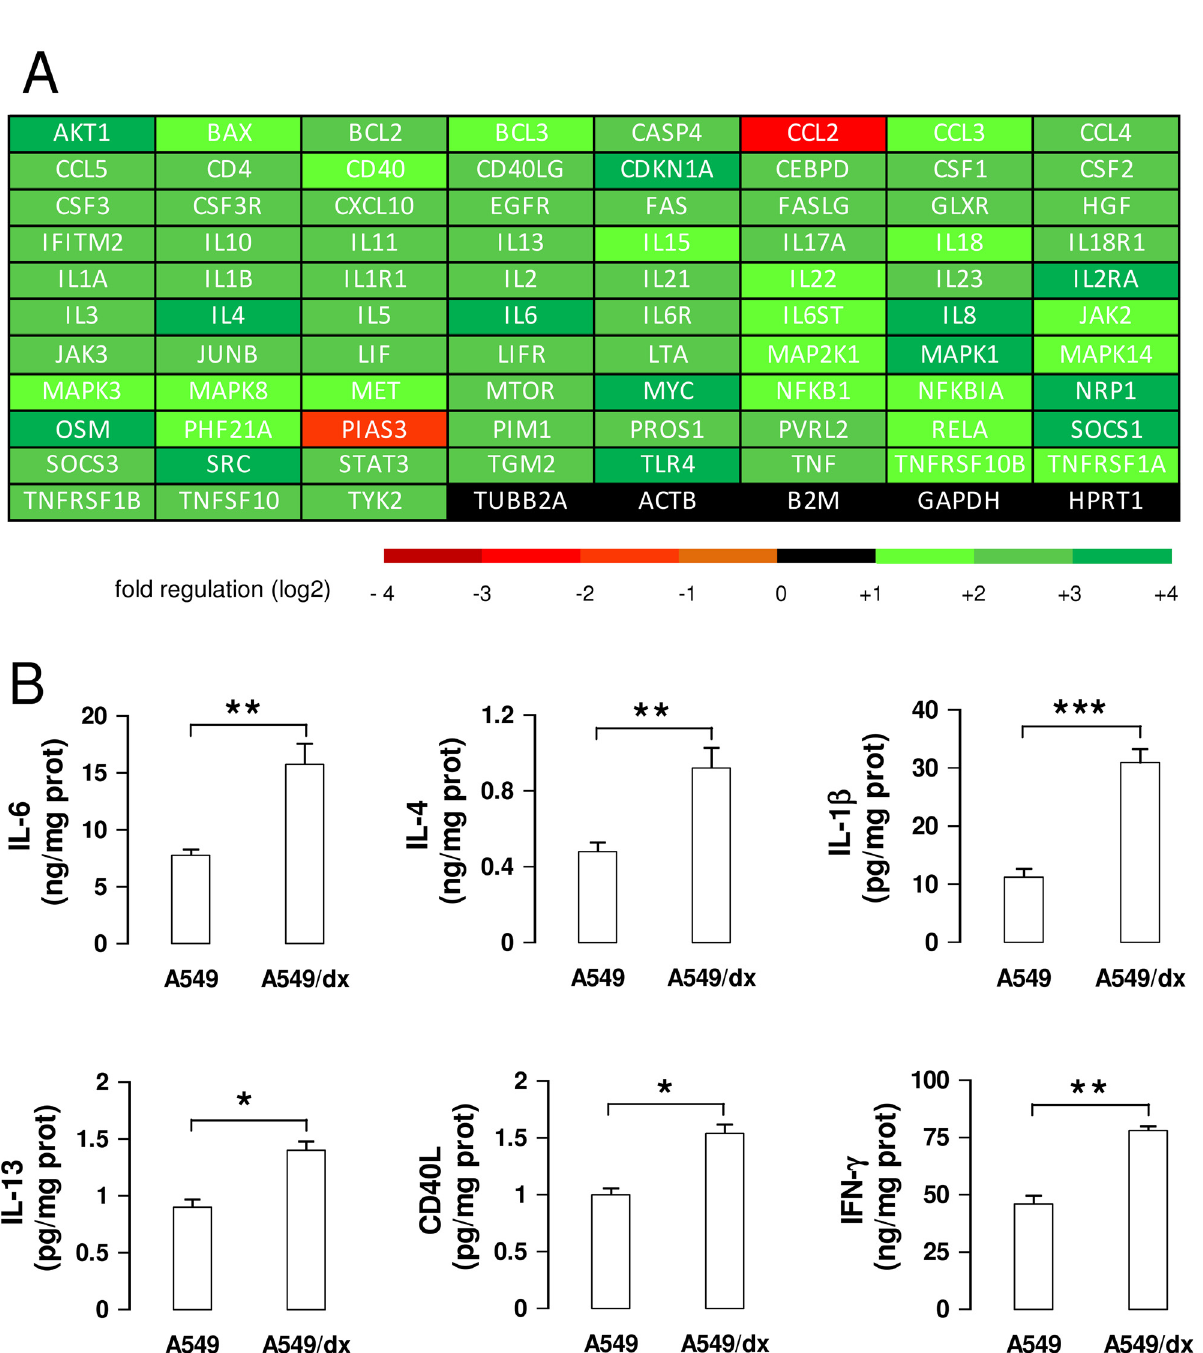
Fig 5. Multidrug resistant cells have a higher activity of IL-6/STAT3 signaling than chemosensitive cells. A. The cDNA from A549 and A549/dx cells was analyzed by a PCR array specific for IL-6/STAT3 signaling, as reported under Materials and methods. The fold regulation of the 83 genes analyzed, expressed in logarithmic scale, was represented in a colorimetric scale. The figure is the mean of 4 experiments. B. The levels of IL-6, IL-4, IL-1 β , IL-13, CD40L, IFN- γ were measured in the cell culture supernatants by specific ELISAs. Data are presented as means ± SD (n = 3). * p < 0.02, ** p < 0.005, *** p < 0.001: A549/dx cells versus A549